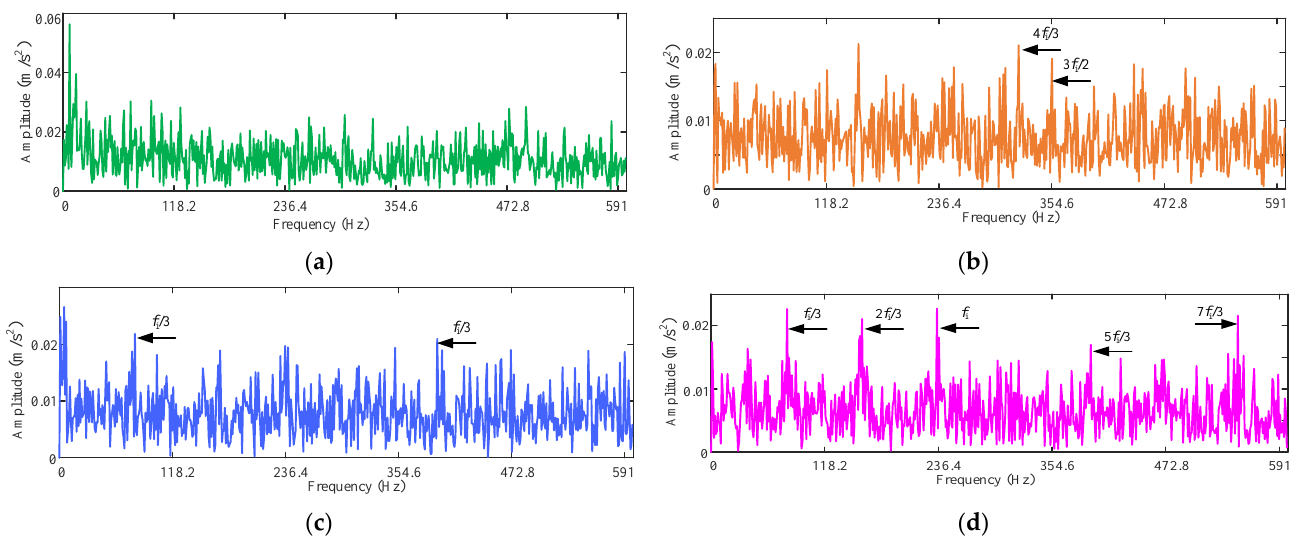
Figure 13. Envelope spectrum of vibration signal and different noise-reduced vibration signals in Case 1. ( a ) Envelope spectrum of vibration signal; ( b ) Envelope spectrum of noise-reduced vibration signal by AG-UNet; ( c ) Envelope spectrum of noise-canceling vibration signal by U-Net; ( d ) Envelope spectrum of noise-canceling vibration signal by TA-UNet.